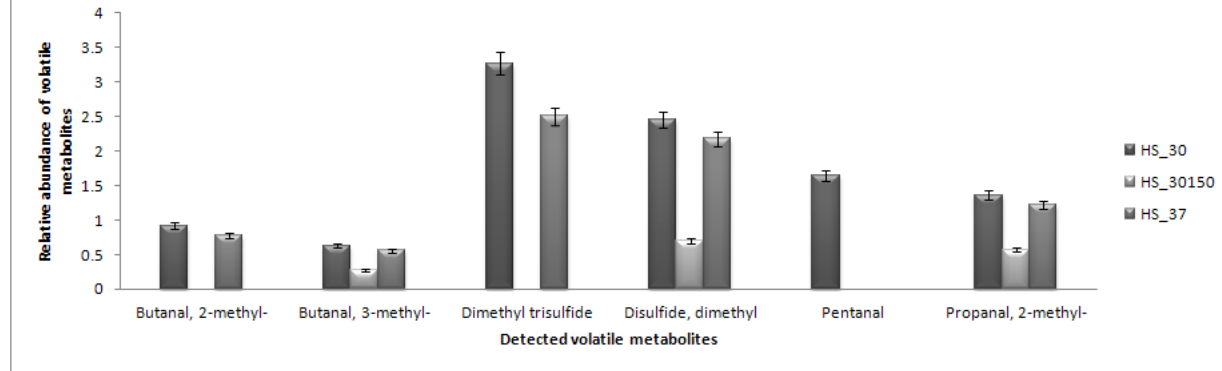
Figure 5. Bar chart representing the relative abundances of detected branched-chain aldehydes using dynamic headspace (HS) coupled to GC-MS according to the three conditions. Condition with agitation showed less production of branched chain aldehydes. HS_30 represents condition of 30 °C, HS_37 represents condition of 37 °C and HS_30150 represents condition with agitation (150